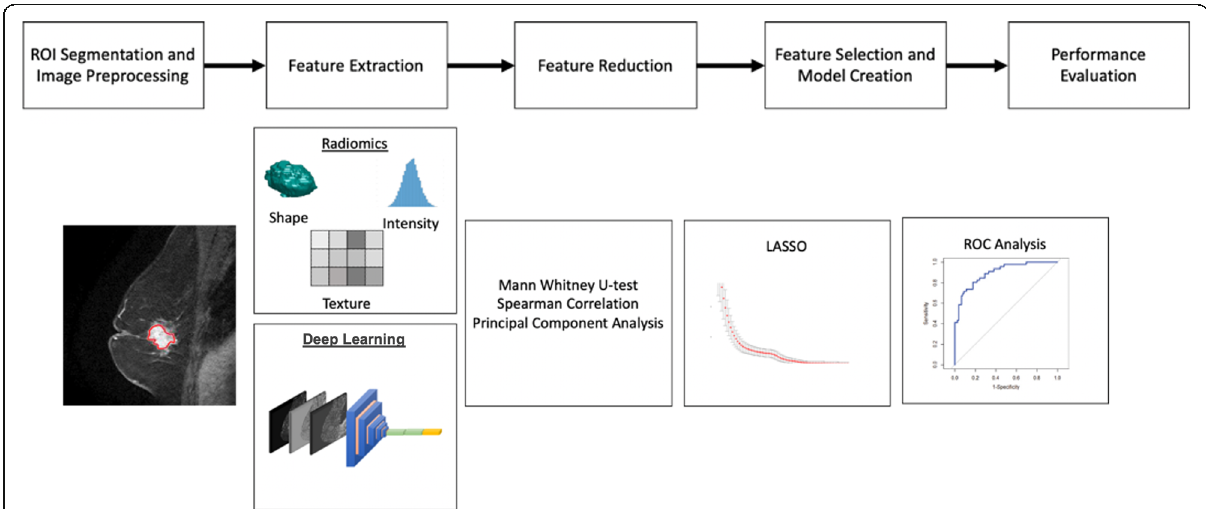
Fig. 1 Schematic representation of pipeline for feature extraction, reduction, and model creation. The CR pipeline and the pipeline using deep learning-based (DLB) features are only different in their feature extraction step. All other steps remain identical. LASSO: Least absolute shrinkage selection operator; ROC: Receiver operating